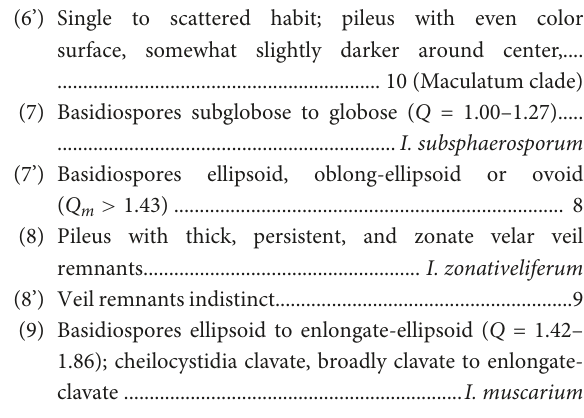
brown background; strong, disagreeable